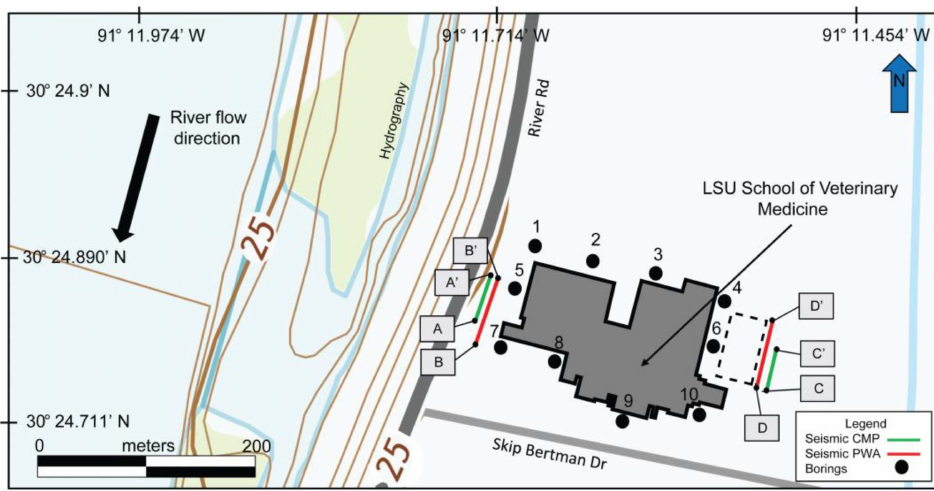
Figure 2. Study area. Seismic and geotechnical data shown in this paper were collected on the eastern side of the artificial levee at the LSU Veterinary School. CMP (common Mid-Point) and PWA (pseudowalkaway) acquisition surveys are denoted with solid lines. Surveys A-A’ and B-B’ were acquired on the west side of the LSU School of Veterinary Medicine building. Surveys C-C’ and D-D’ were acquired on the east side of the building. We use data from ten (10) geotechnical wells (numbered black circles) that include laboratory physical properties (Figure 3). The rectangle with dashed lines is the parking lot east of the Veterinary school with visible surface cracks with water leaks during the high river